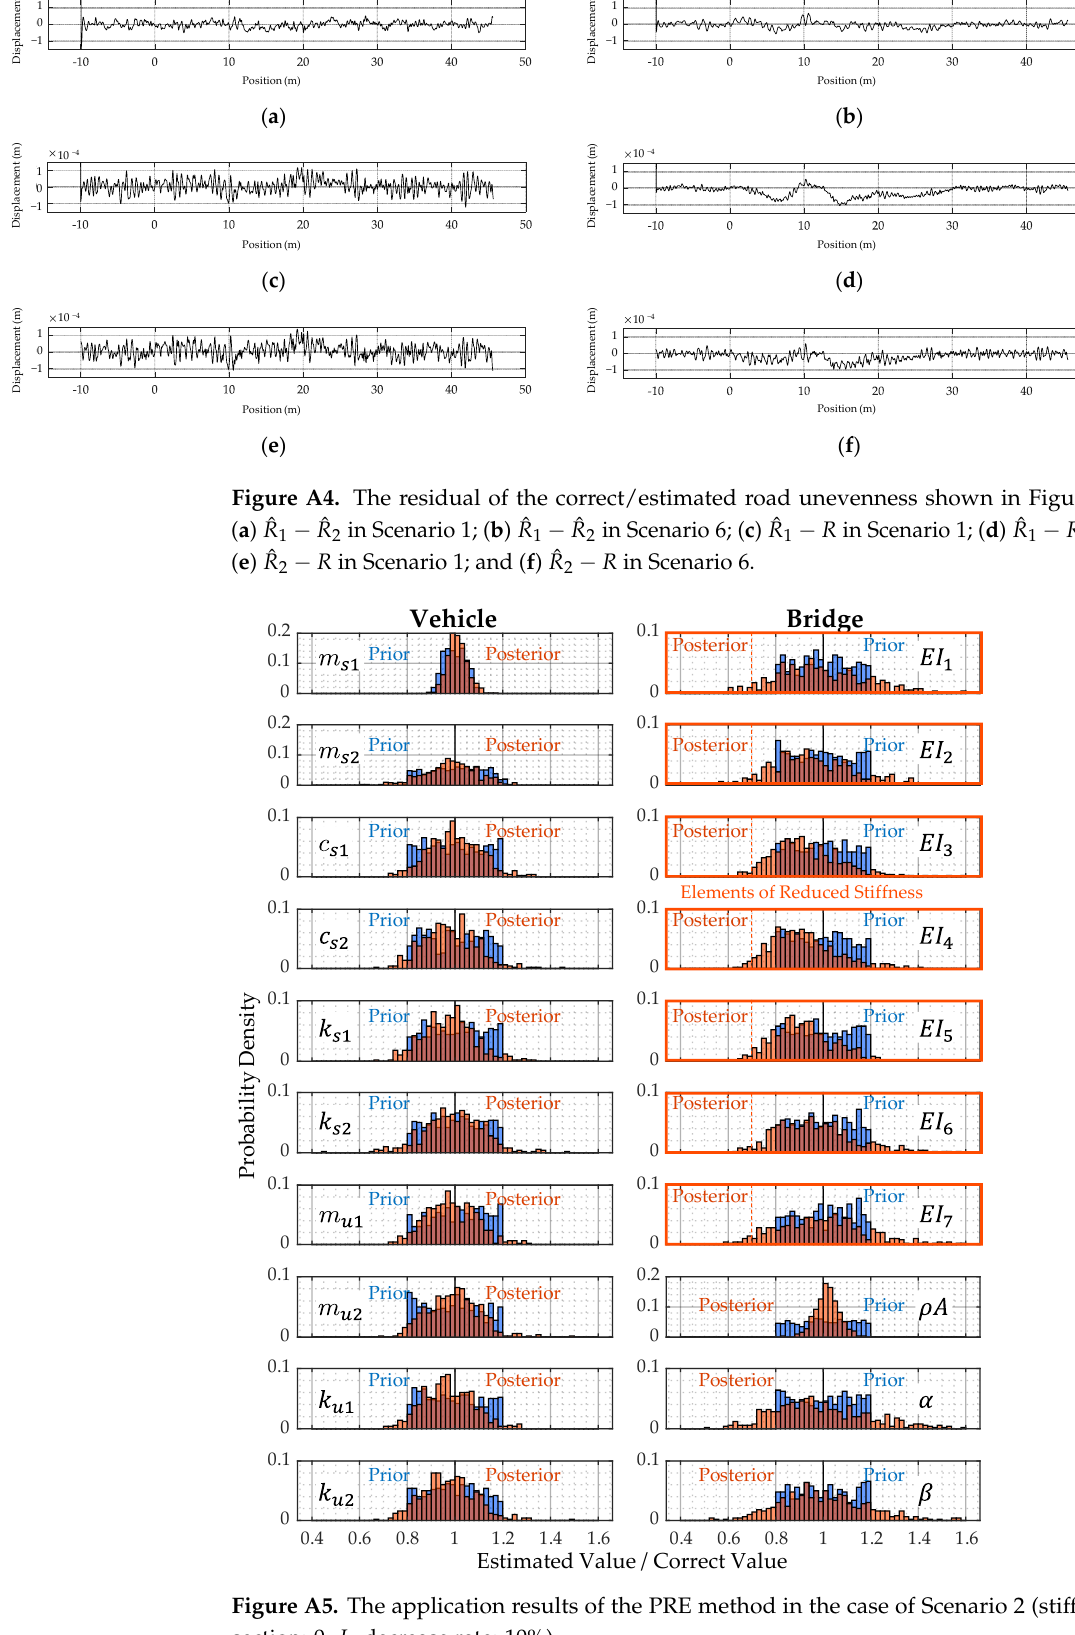
Figure A3. Enlarged view of Figure 6a 𝑧(cid:4663) (cid:3046)(cid:2869) (𝑡) and Figure 7c showing the power spectrum of 𝑧(cid:4663) (cid:3048)(cid:2869) : ( a ) Figure 6 ; ( b ) Figure 7. The differences in the vehicle responses between different scenarios are tiny because the influence of fixed road profiles is predominant. Figure A4 shows the differences between correct and estimated road unevenness functions. According to these figures, the estimation errors are less than 0.1 mm in most positions.